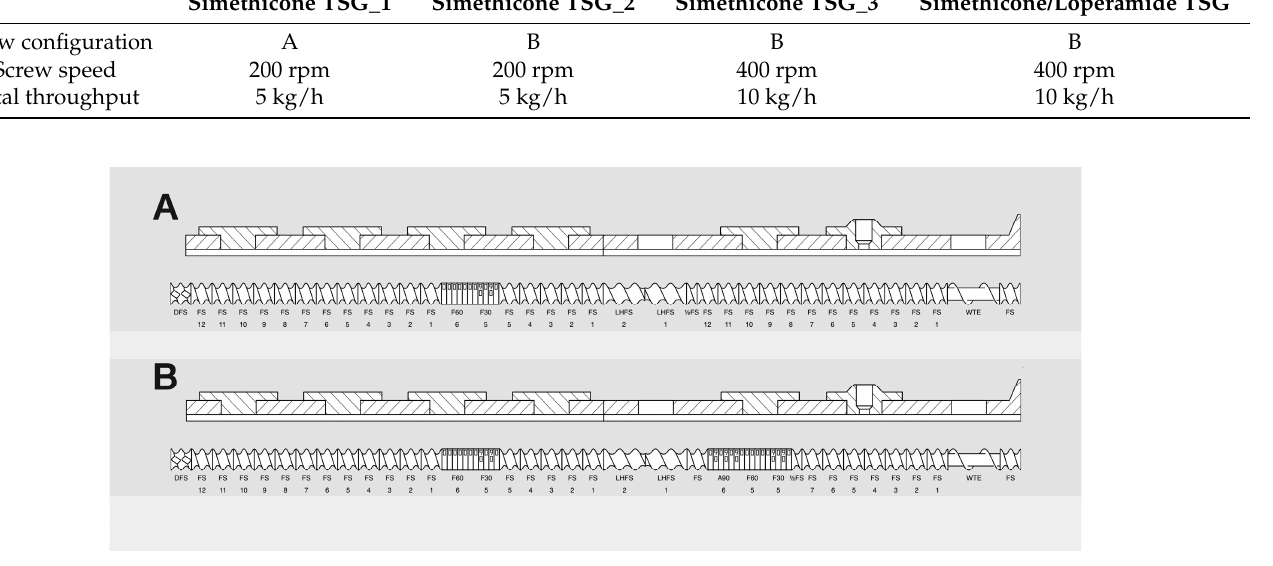
Figure 2. Schematic diagram of the screw con fi guration with one ( A ) or two ( B ) kneading zones and corresponding barrel set-up (prepared in Twin Screw Con fi gurator software version 1.34 (6) from Thermo Fisher Scienti fi c, Karlsruhe, Germany).